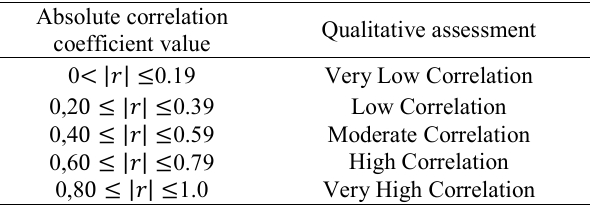
Table 2. Pearson Correlation Scale [16].